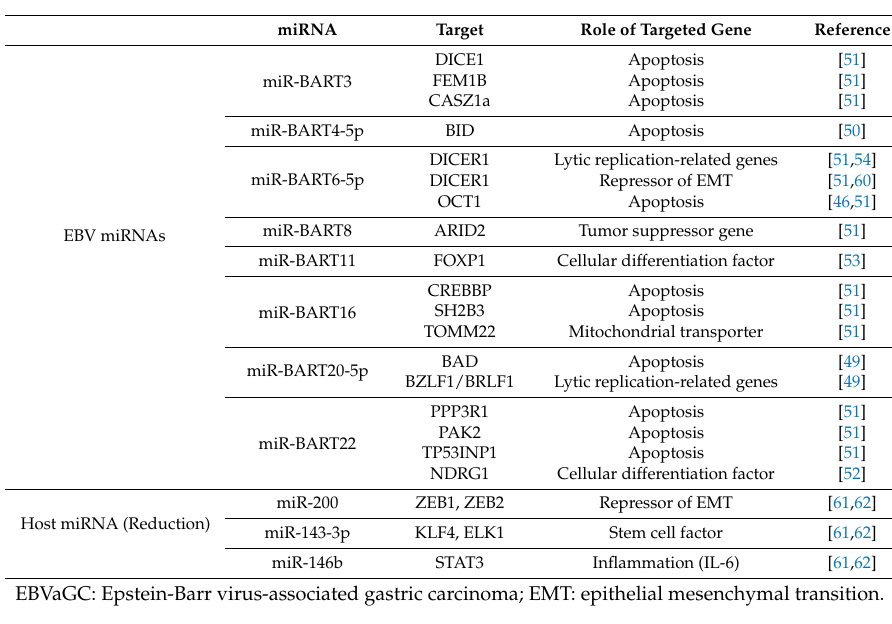
Table 2. The role of miRNAs in EBVaGC.